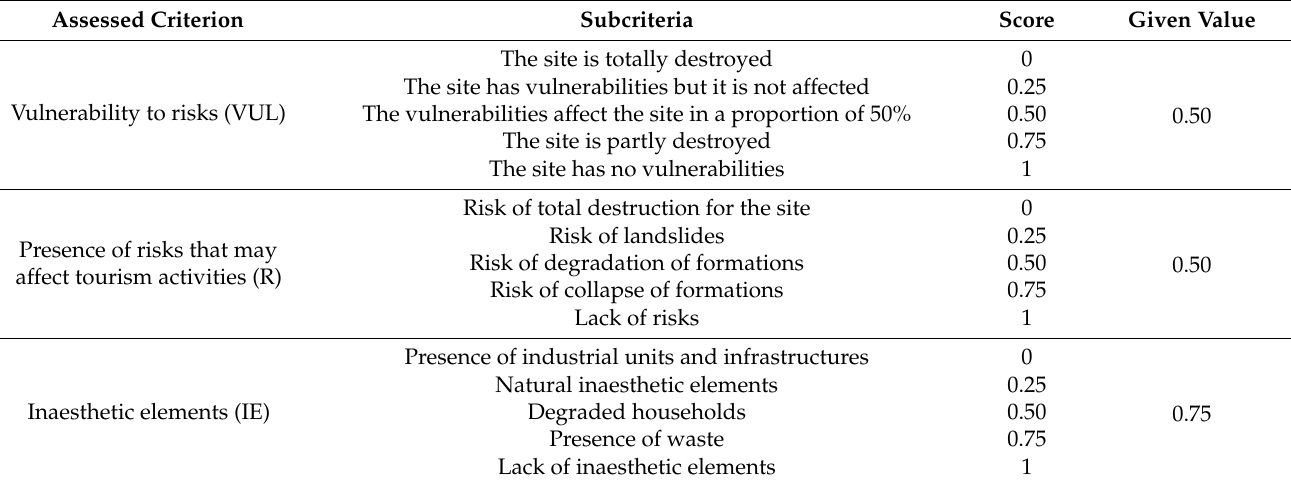
Table 7. The analysis of restrictive features (V AR